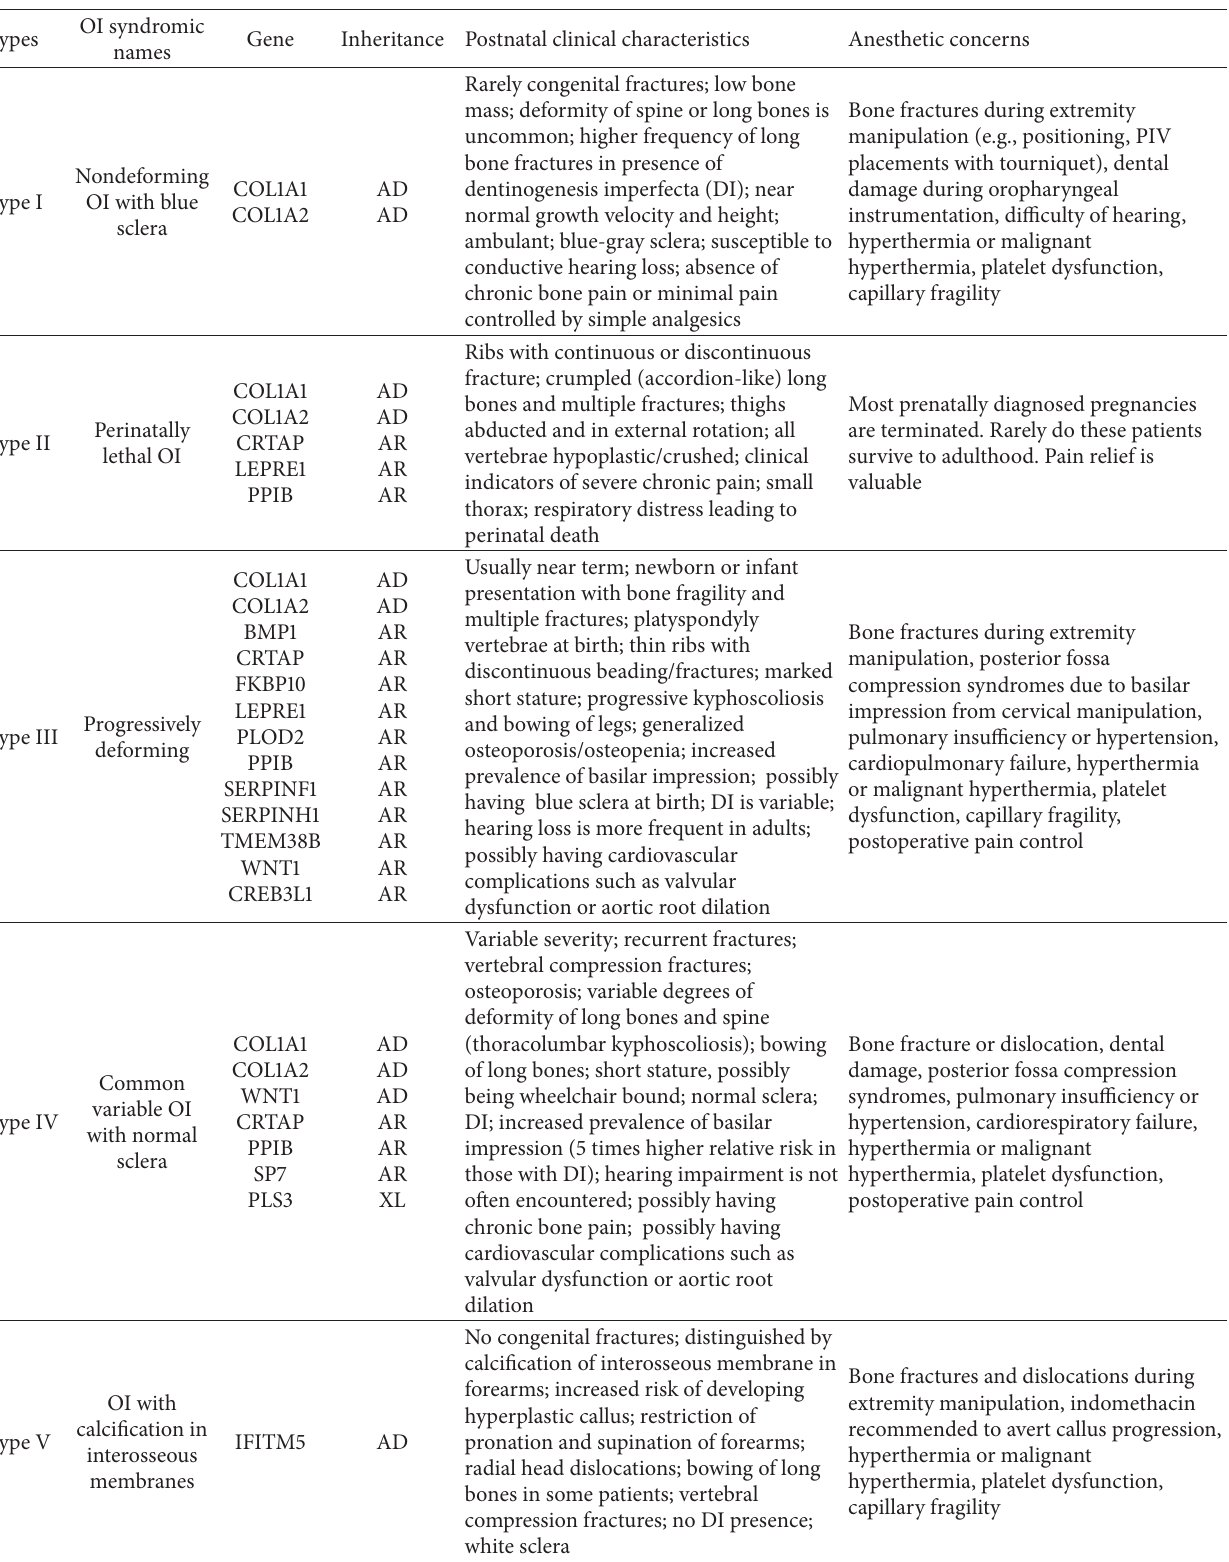
Table 1: Classification of osteogenesis imperfecta and related anesthetic concerns [4,